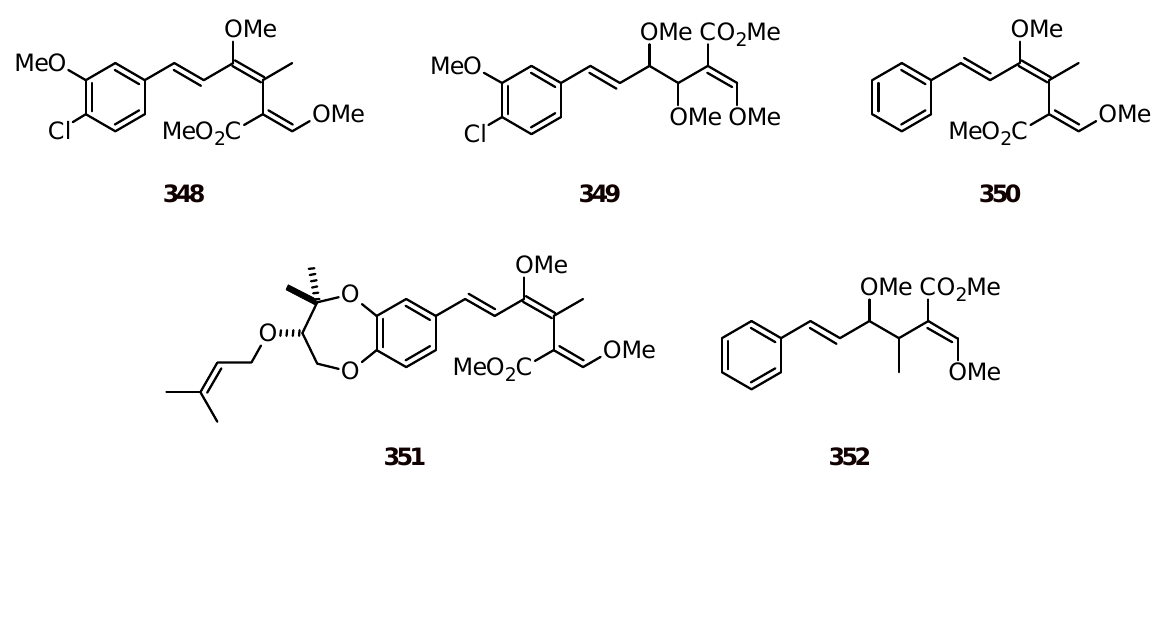
Figure 41. Structures of strobilurins 348 - 352